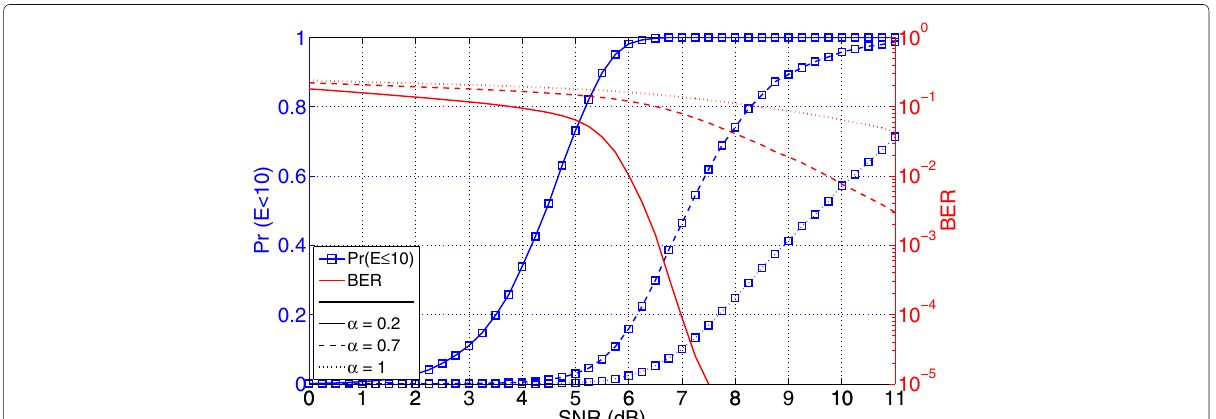
Fig. 6 BE-CDF bc calculated when t = 10 for three different effective jamming powers. These results anticipate the likelihood of decoder failure for Eve at α = 0.7 for a BCH(127,64) code at around 0.9952 when Eve’s Gaussian channel has SNR = 4 dB. If Bob experiences an effective α = 0.2, then he can operate with BE-CDF bc = 0.9975 at 6.5